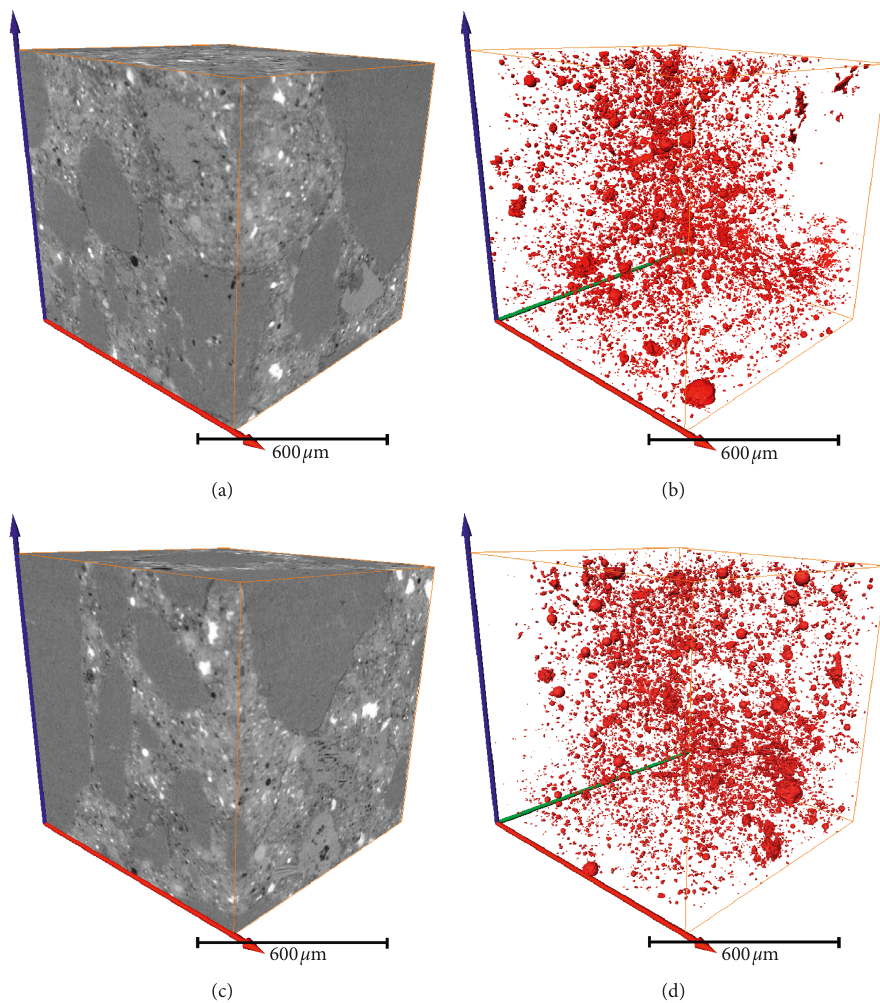
Figure 1: Raw images and segmented porous volume of hardened cement paste by